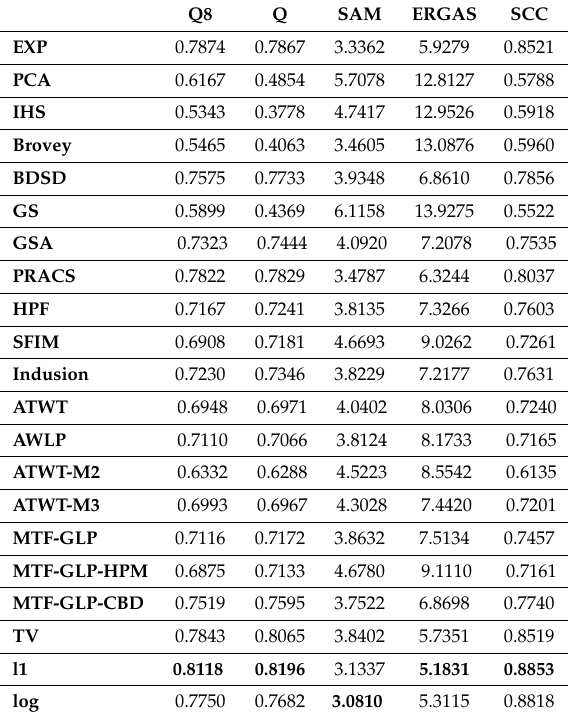
Table 6. Quantitative results using Wald’s protocol on the LANDSAT 7-ETM+ Netherland image in Figure 2c. Bold values indicate the best score.